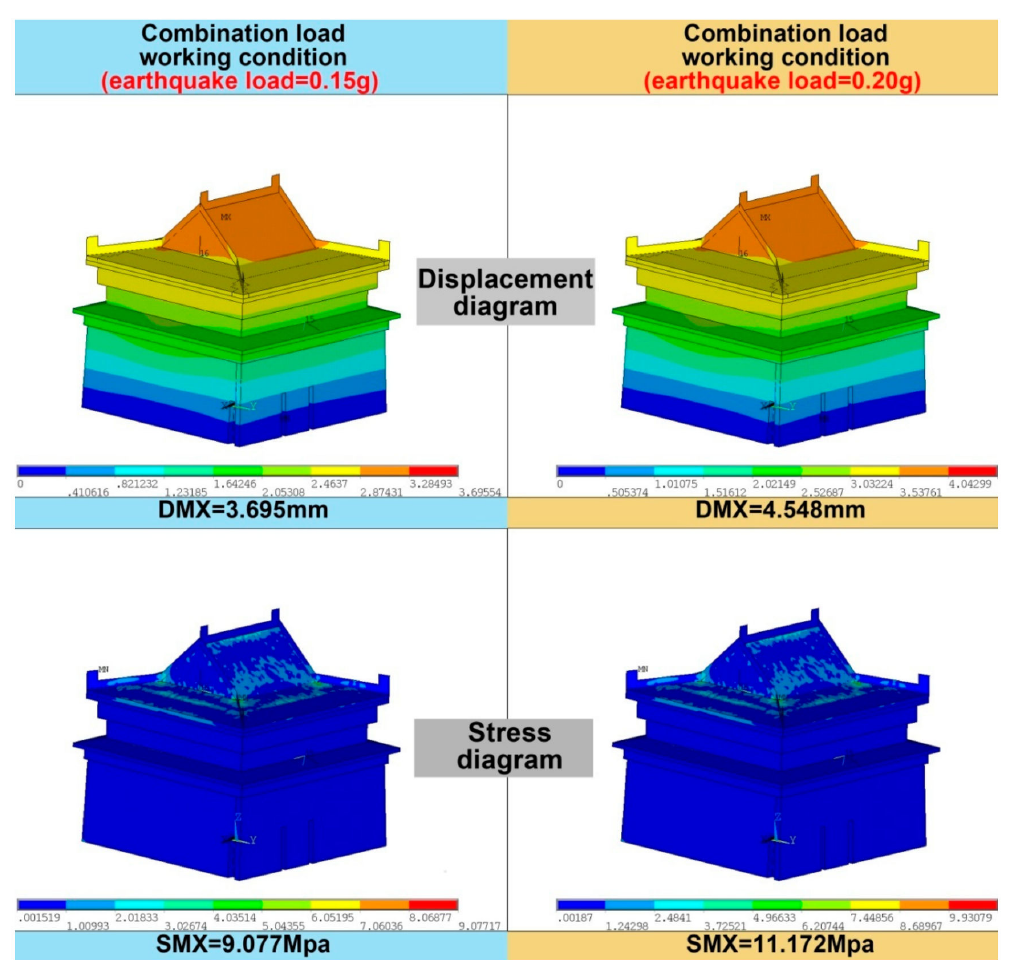
Figure 21. Displacement diagram and stress diagram of the Limestone Hall under current status with earthquake accelerations of 0.15 g and 0.2